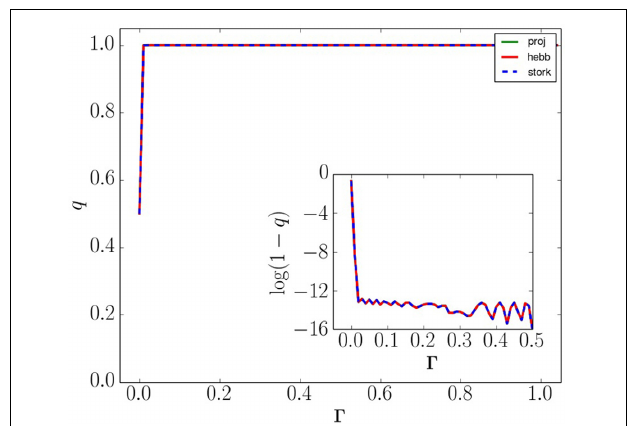
FIGURE 4 | Probability q to recall the correct memory with respect to applied bias (cid:3) for n = 4 neurons and p = 2 memories from the set in Equation (23). All three learning rules coincide and show unit recall success for (cid:6) > 0 . 10. Inset: a semi-log plot showing how recall error decreases with applied bias. Numerical noise dominates the inset plot beyond (cid:6) ≈ 0 . 4